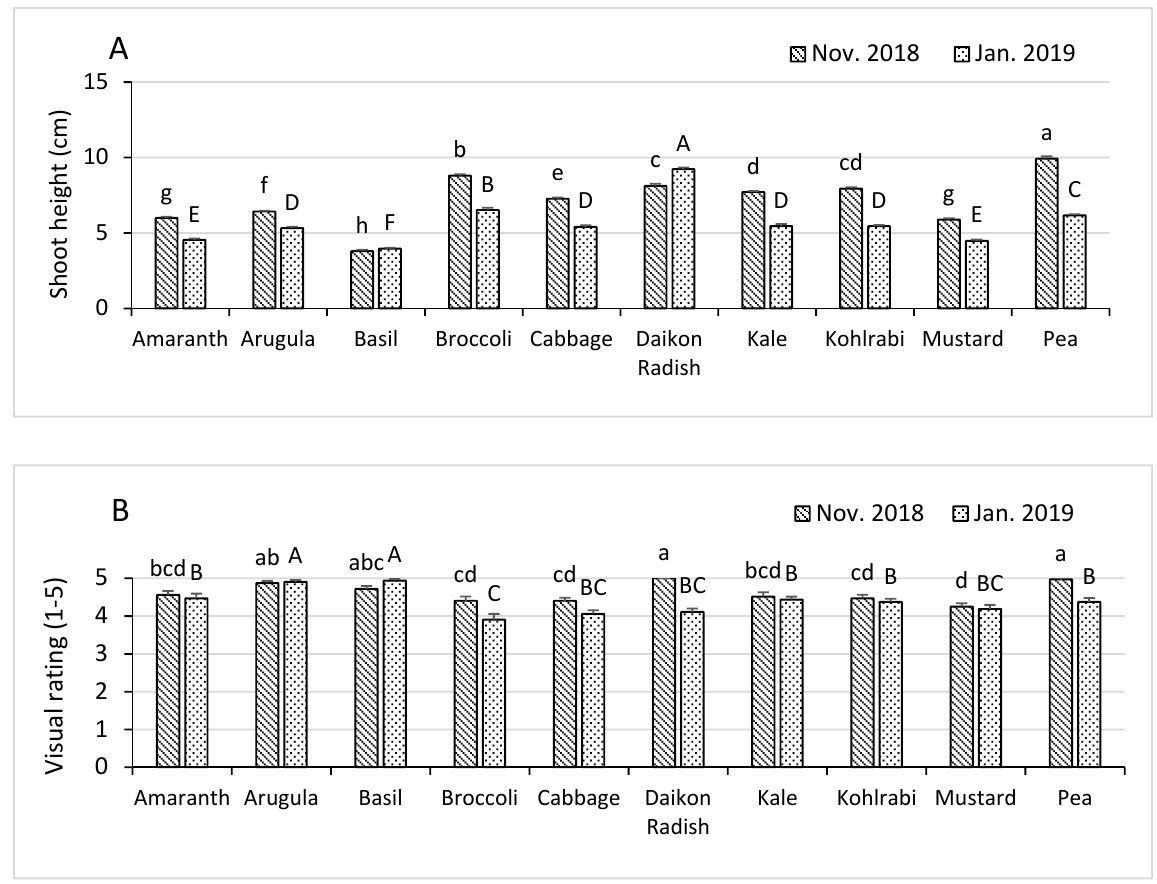
Figure 2. Shoot height ( A ) and visual rating ( B ) of ten species grown as microgreens. Means with standard error bars of each species were obtained by averaging data from both fertilization and pre-sowing seed treatments. Different lower case or capitalized letters suggest significant difference among species indicated by Tukey’s HSD test at α ≤ 0.05 in November 2018 or January 2019, respectively.